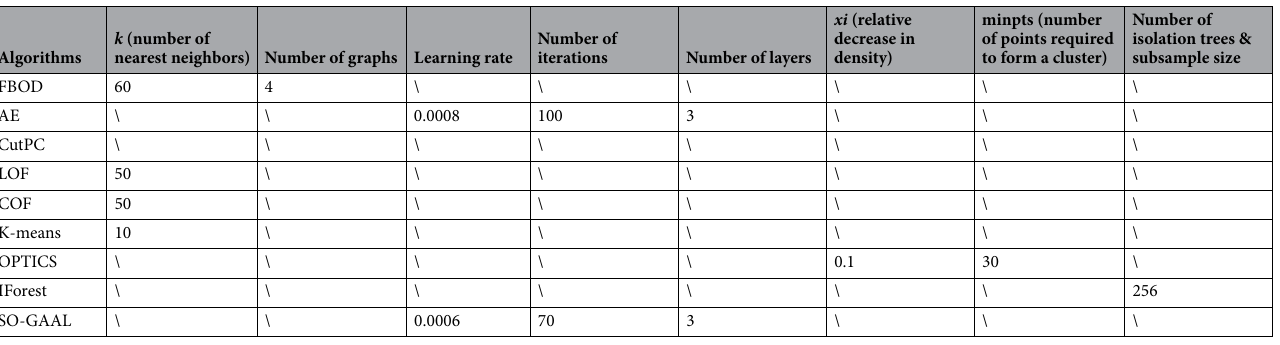
Table 5. Optimal parameter